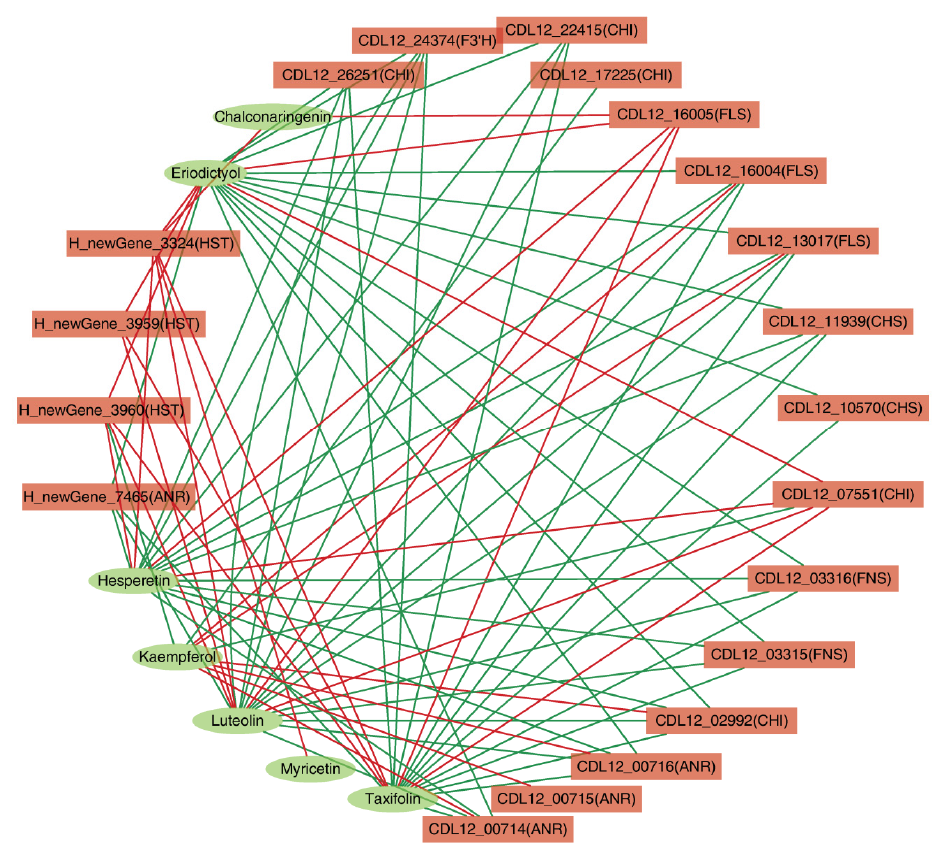
Figure 10. Correlation analysis of differentially accumulated metabolites (DAMs) and differentially expressed genes (DEGs) involved in flavonoid biosynthesis. Positive correlations are indicated by red lines, and negative correlations are indicated by green lines. Red highlights indicate genes, and green highlights indicate metabolites.